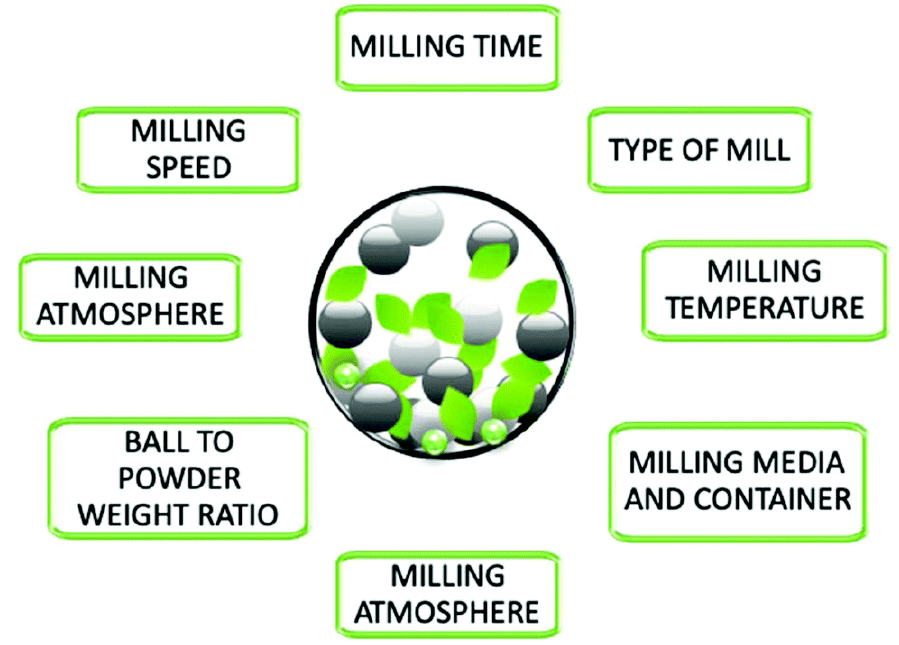
Figure 8. Parameters of the mechanochemical processing of vegetable raw materials [66].